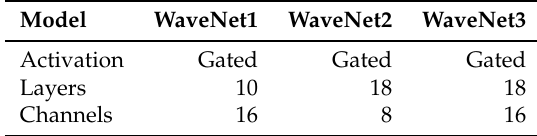
Table 1. Hyperparameters of selected neural